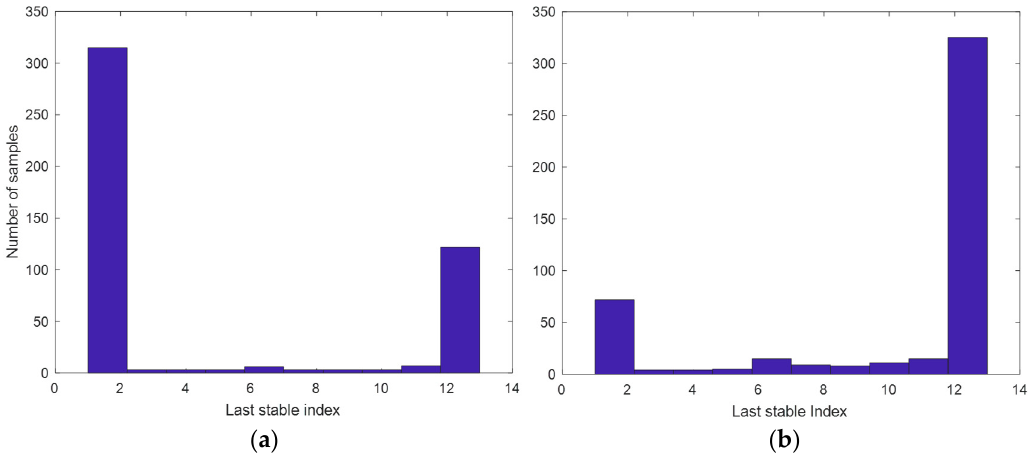
Figure 23. Histogram of the last stable index: ( a ) sunny day; ( b ) cloudy day